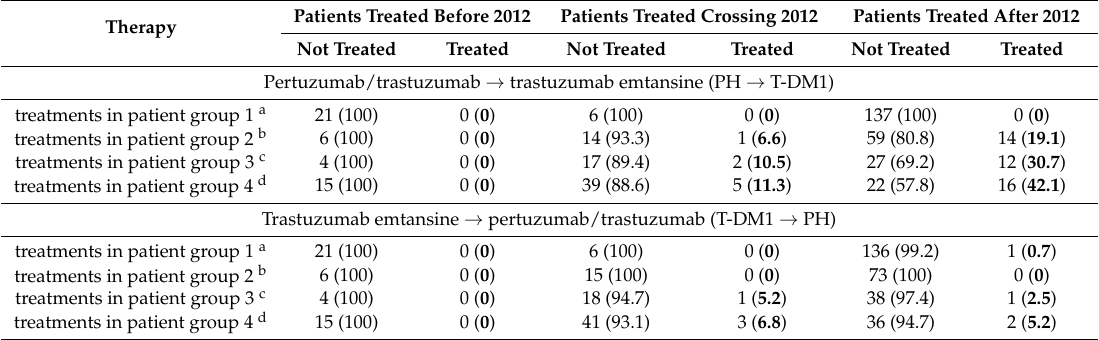
Table 3. Frequencies of patients who were treated with the respective treatment sequences, irrespective of whether the sequences were administered directly after each other. The patients are categorized into four mutually exclusive patient groups according to the numbers of documented therapy